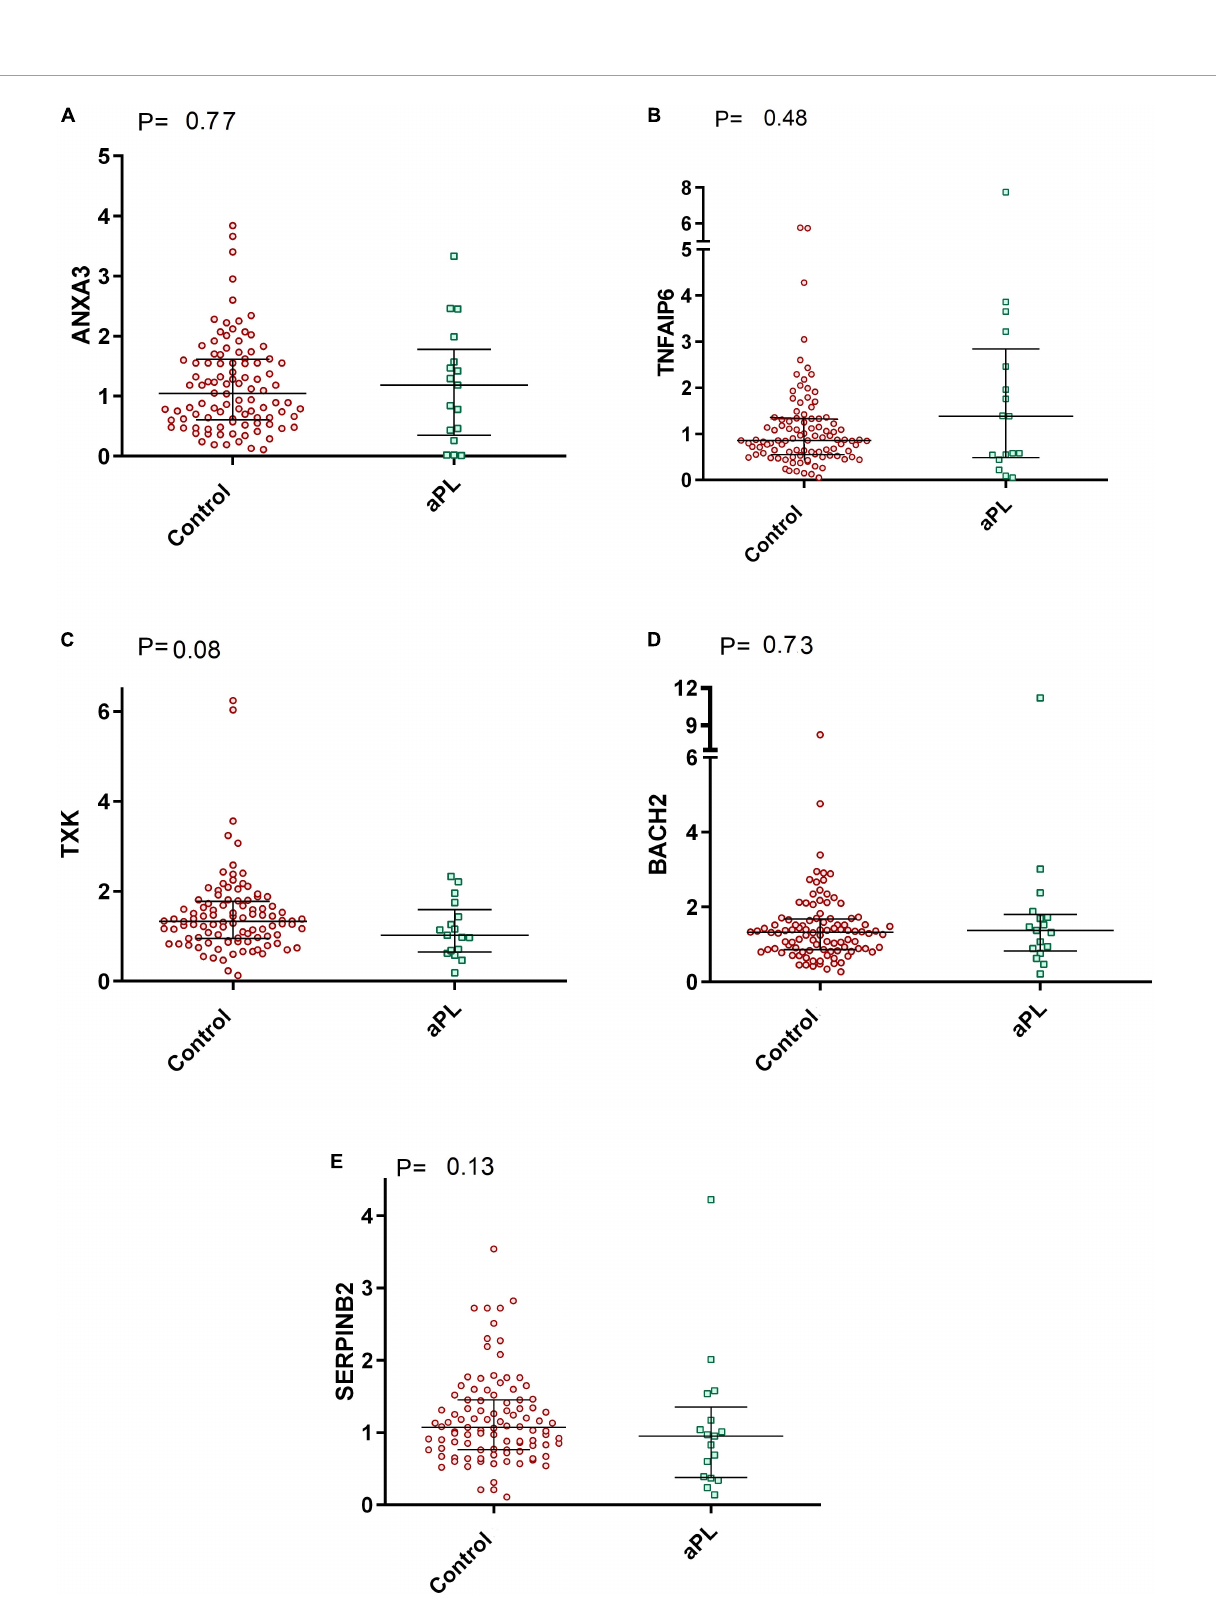
FIGURE3 Comparative graphs of the expression of genes related to thrombosis. Legend: Relative expression of the genes (A) ANXA3 , (B) TNFAIP6 , (C) TXK, (D) BACH2, and (E) SERPINB2 in total leukocytes was evaluated in aPL carriers compared to controls. Median and IQR were used by the Mann-Whitney test. aPL, asymptomatic aPL carriers (aPL +). The median relative expression of the ANXA3 gene was 1.04 (IQR 0.60–1.61) in control subjects and 1.18 (IQR 0.34–1.78) in aPL + subjects. The relative expression of TNFAIP6 was 0.86 (IQR 0.55–1.32) in controls and 1.38 (IQR 0.49–2.84) in aPL +. The relative expression of TXK was 1.33 (IQR 0.95–1.77) in controls and 1.02 (IQR 0.65–1.59) in aPL + patients. BACH2 relative expression was 1.32 (IQR 0.86–1.68) in controls and 1.38 (IQR 0.82–1.80) in aPL +. Finally, the relative expression of SERPINB2 was 1.07 (IQR 0.76–1.45) in controls and 0.95 (IQR 0.38–1.35) in aPL